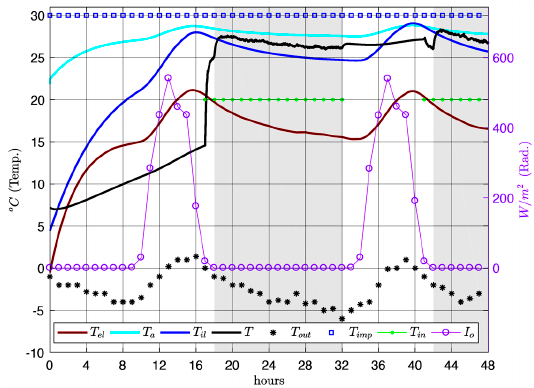
Figure 5. Case 1: Le Corbusier hypothesis. Winter. Data: calculated temperatures: T el , T a , T il , T at a height of 1.5 m, outdoor temperature T out , impulse temperature T imp , inlet temperature T in , all of them against the left y -axis, and radiation I o against the right y -axis.